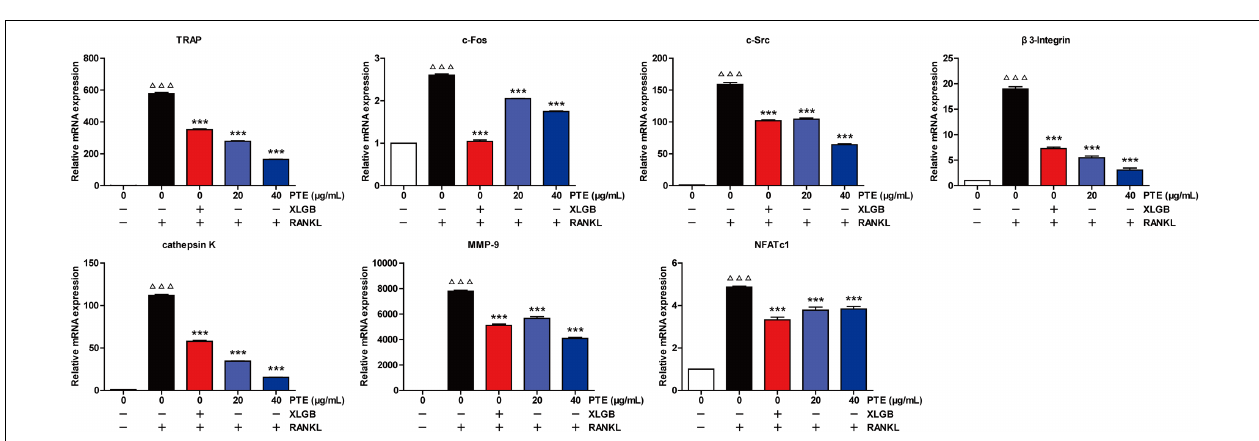
FIGURE 5 | Pu-erh tea extract suppressed the RANKL-induced mRNA expression of osteoclast-specific genes. Values are shown as the mean ± SEM of three independent experiments. (cid:77)(cid:77)(cid:77) P < 0.001 versus the control; and ∗∗∗ P < 0.001 versus only RANKL-treated